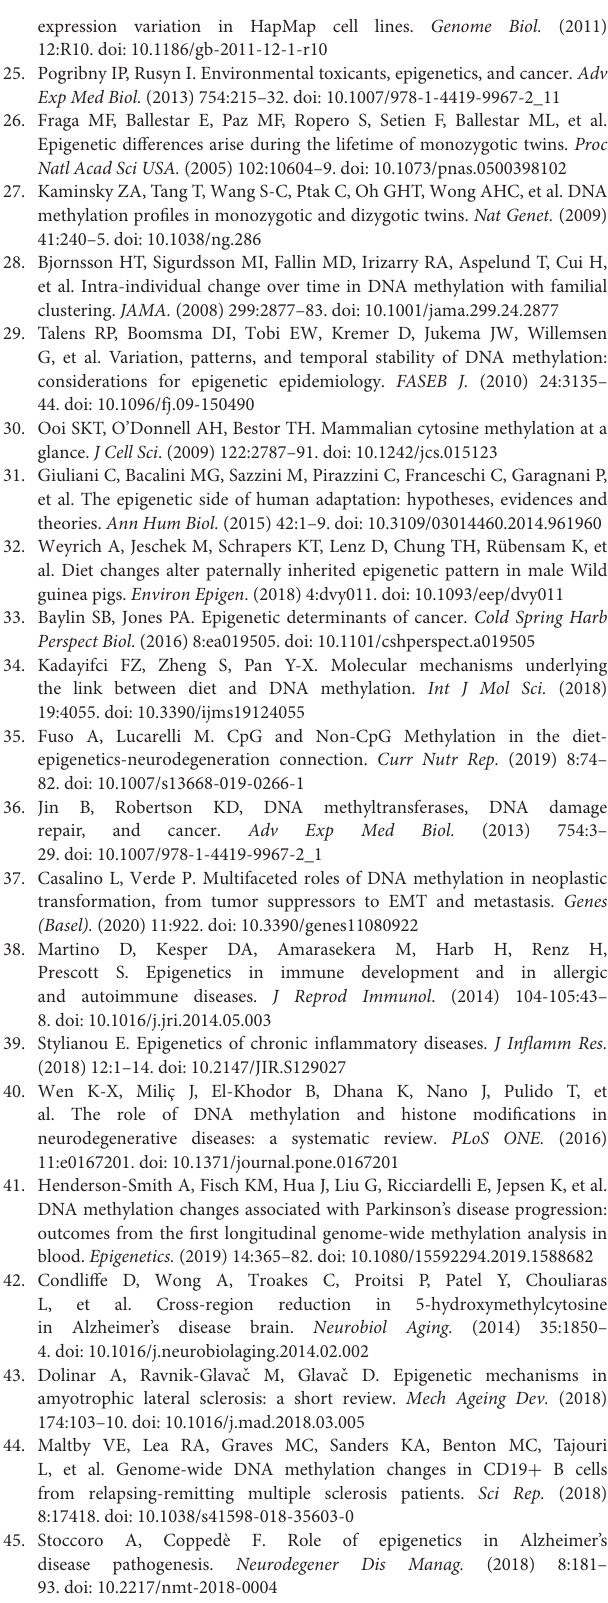
CurcuminmodulatesDNAmethylationincolorectalcancercells. PLoSONE. (2013) 8:e57709. doi: 10.1371/journal.pone.0057709 63. Kumar U, Sharma U, Rathi G. Reversal of hypermethylation and reactivation of glutathione S-transferase pi 1 gene by curcumin in breast cancer cell line. Tumour Biol J Int Soc Oncodevelopmental Biol Med. (2017) 39:1010428317692258. doi: